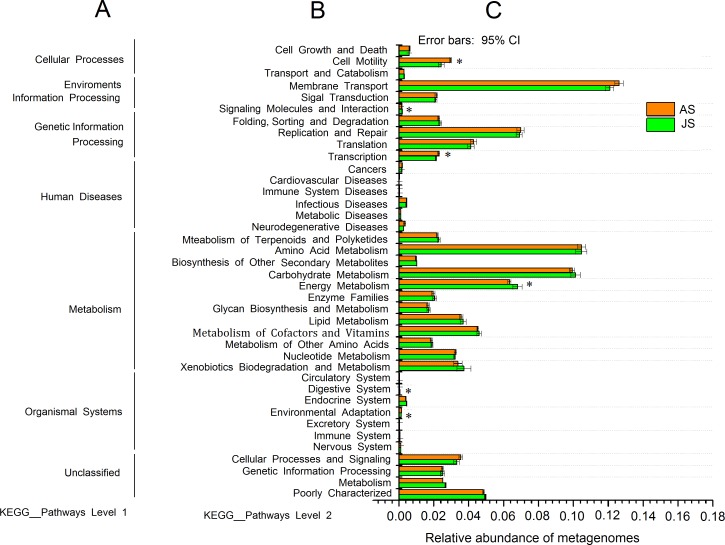
PICRUSt predictions of the functional composition of snails microbiome.(A) represents KEGG pathway at level 1, (B) represents KEGG pathway at level 2, and (C) represents the abundance of each function pathway. Study sites: JS, juvenile snails; AS, adult snails.